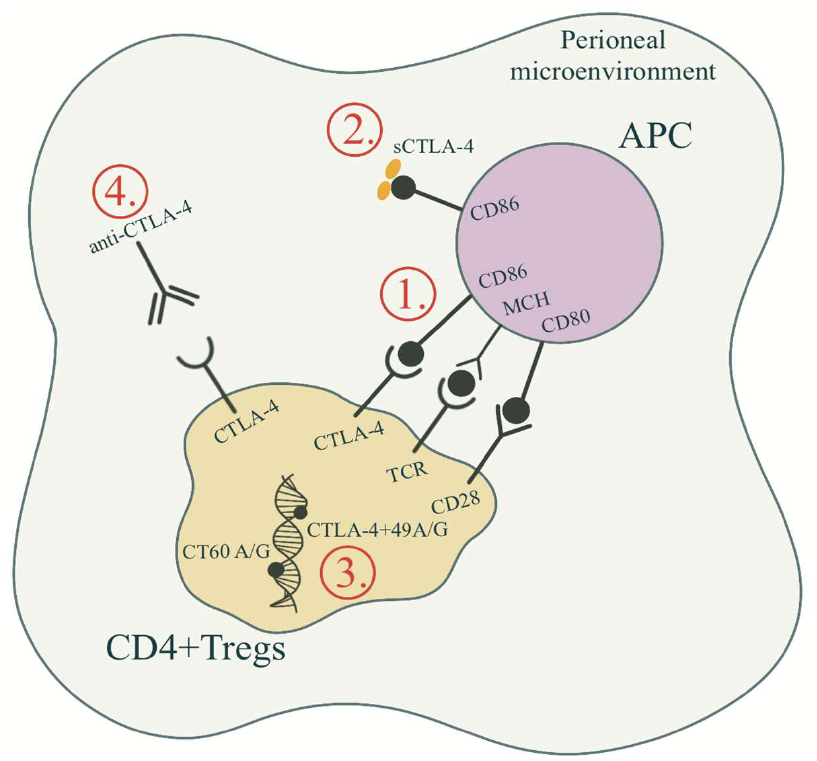
Figure 2. The mechanisms of CTLA4 involvement in the pathogenesis of endometriosis. (1) The CTLA4 expressed on the surface of T cells involved in inhibitory co-stimulatory signal in T cell proliferation; (2) Higher serum and peritoneal soluble form of CTLA4 (sCTLA4) found in advanced endometriosis and related infertility; (3) CTLA4 gene polymorphisms not associated with the pathogenesis of endometriosis; (4) Anti-CTLA4 antibodies in mouse endometriosis model found to reduce the number of Treg cells and thus inhibit proliferation and invasion of ectopic endometrium. (Original illustration) .